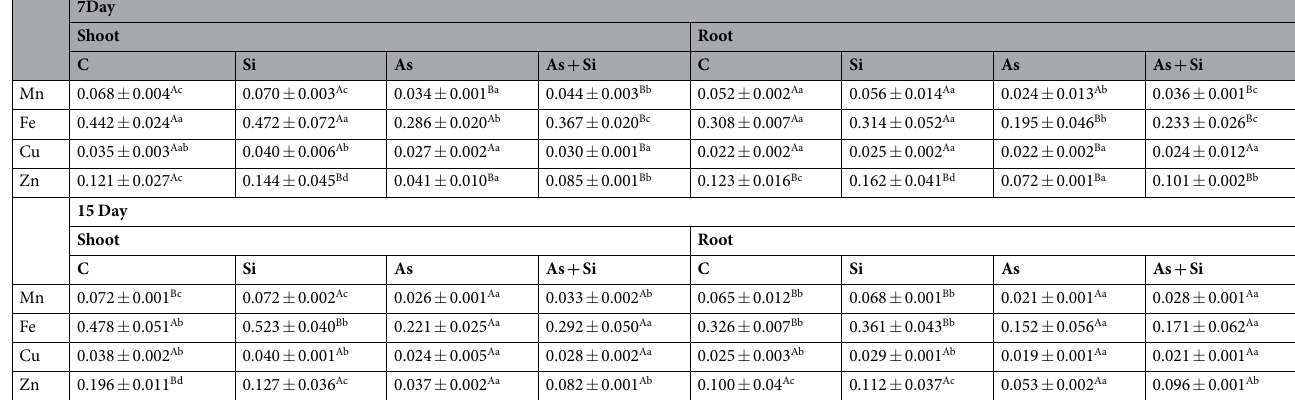
Si treatment decreased As(III)-induced LOX activity, MDA content and alters antioxidant activ- ities. LOX, an oxidative enzyme leads to the formation of MDA. In As (III) treated plant, LOX activity increased both in shoots and roots at 7 and 15 d (Fig. 6A). Significant reduction was observed under As (III) + Si combination